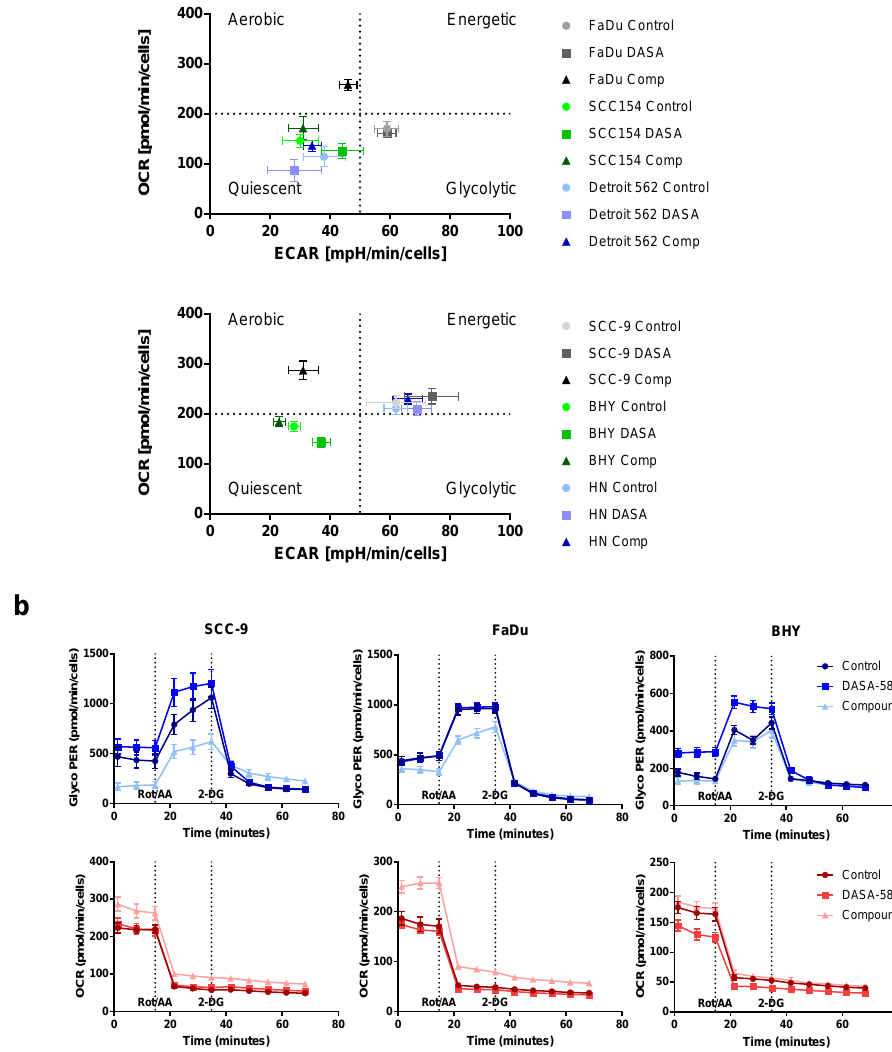
Figure 4. Influence of DASA-58 and Compound 3k on HNSCC metabolism. ( a ) Indicated HNSCC cell lines were treated for 5 h with 30 µM Compound 3k (Comp), 30 µM DASA-58 (DASA) or with vehicle alone (Control) and were subsequently measured in a real-time cell metabolic analyzer. Basal ECAR values were plotted against the corresponding OCR values. Graphs are divided into four areas (dotted lines) to define different metabolic groups. ( b ) Representative selection of results of glycolytic rate assays performed with different HNSCC cell lines after 5 h of stimulation with Compound 3k, DASA-58 or with vehicle alone (Control). GlycoPER kinetic graphs in blue, corresponding OCR kinetic graphs below in red. Dotted lines indicate time points of injections of Rotenone in combination with Antimycin A (Rot/AA) and 2-Desoxy-D-Glucose